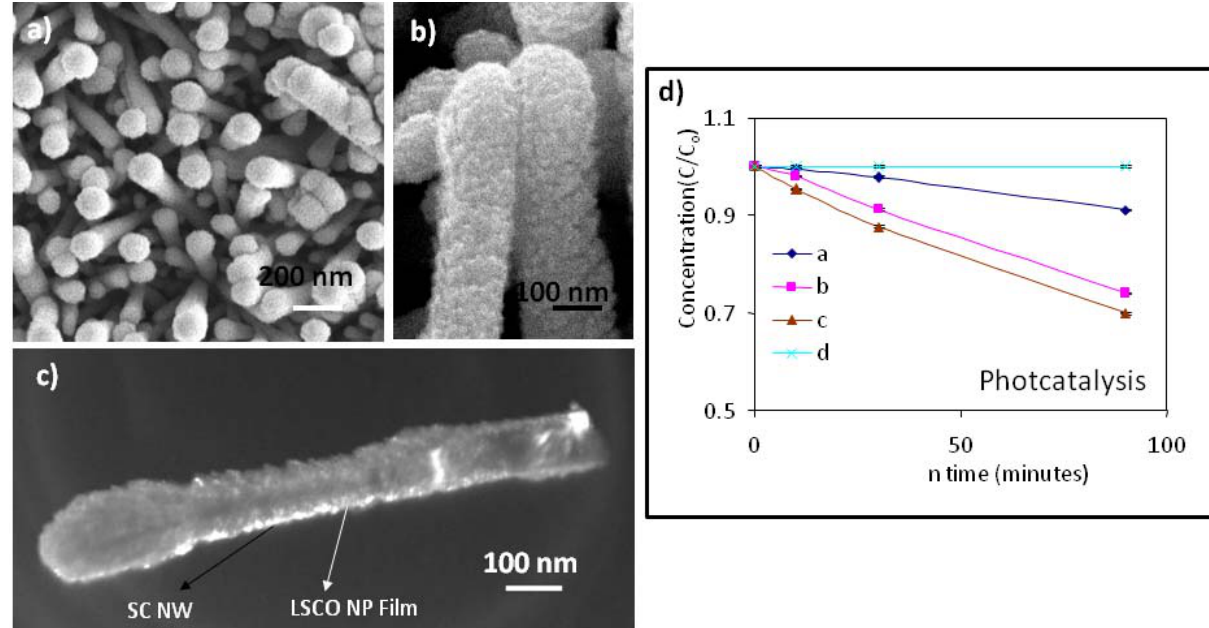
Figure 6. Top view ( a ) and side view ( b ) SEM images of ZnO/LSCO composite nanorod arrays based on ZnO nanorod arrays with a nanorod diameter of ~100 nm; ( c ) A dark field TEM image of an individual ZnO/LSCO composite nanorod indicating the bright regions corresponding to the dispersed LSCO nanoparticles with a grain size in a range of ~10–20 nm; ( d ) Photodegradation of methyl orange in the presence of (a) ZnO nanorod arrays, (b) LSCO thin film, (c) ZnO/LSCO composite nanorod arrays, and (d) a blank